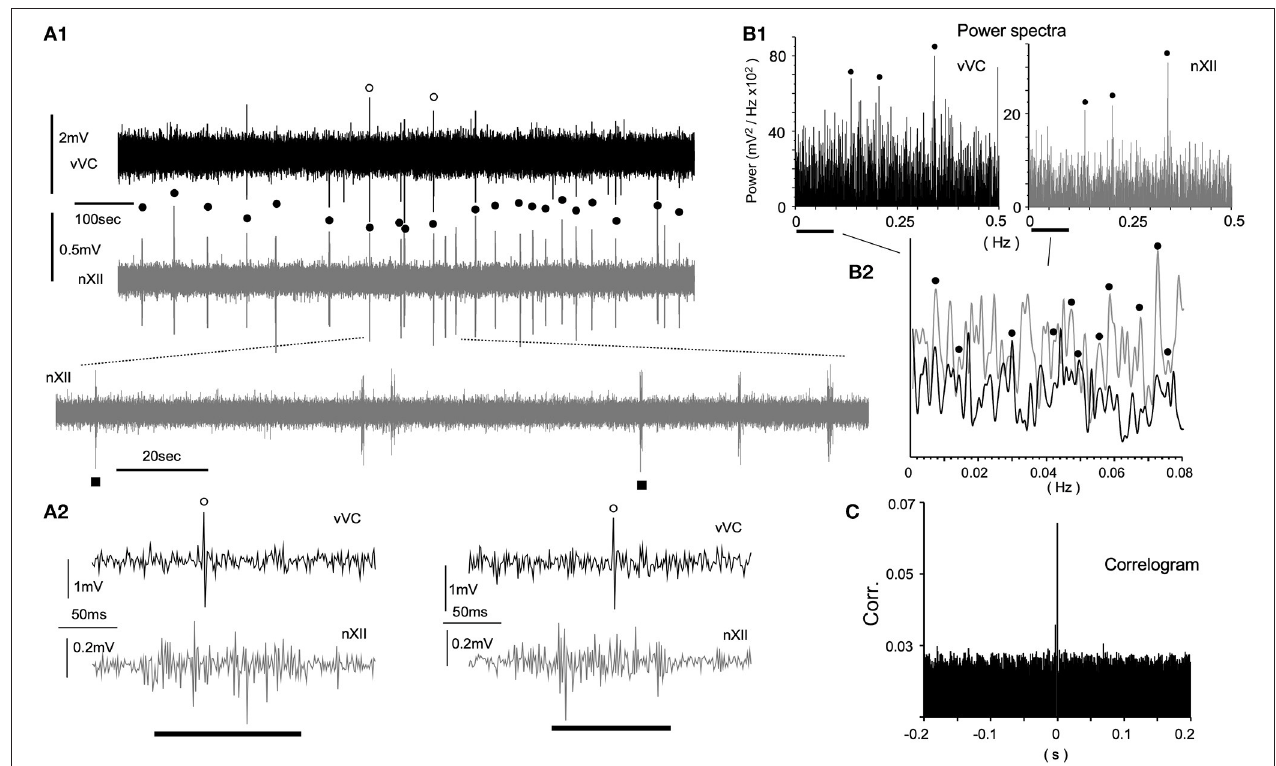
FIGURE 4 | Spontaneous neuronal activities of the ventral vagal complex (vVC) synchronized with presumed respiratory rhythms recorded in an in vitro ponto-medullary block. (A) Simultaneous recordings of a vVC neuron and hypoglossal nerve rootlets (nXII; in gray) reveal synchronous activities (solid circles) between them. Expanded traces ( A1 lower and A2 ) show concurrent single (vVC) and multiple (nXII) spikes. (B) Power spectrum analyses (Power) of vVC and nXII (in gray) activities over slow (B1) and slower (B2) frequency ranges. A vertical axis in (B2) is arbitrarily set for a comparison of peaks of the two sets of power. Synchronous peaks of power spectra are marked by solid circles (B1,2) . (C) A correlogram (Corr.) of vVC and nXII activities. three successive 10 s windows, from pairs of adjacent recording